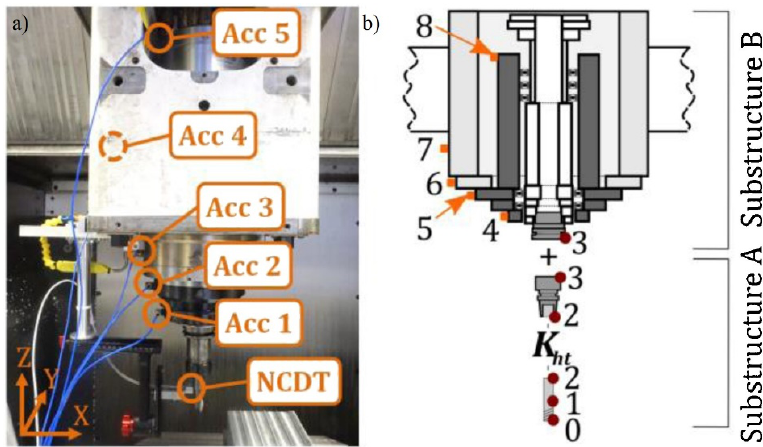
Figure 3. ( a ) Real image with the position of the five accelerometers and one non-contact displacement transducer (NCDT) indicated in the machine’s spindle. ( b ) Scheme of the spindle (divided into two substructures) with 8 positions indicated for the calculation of the Frequency Response Function [55].